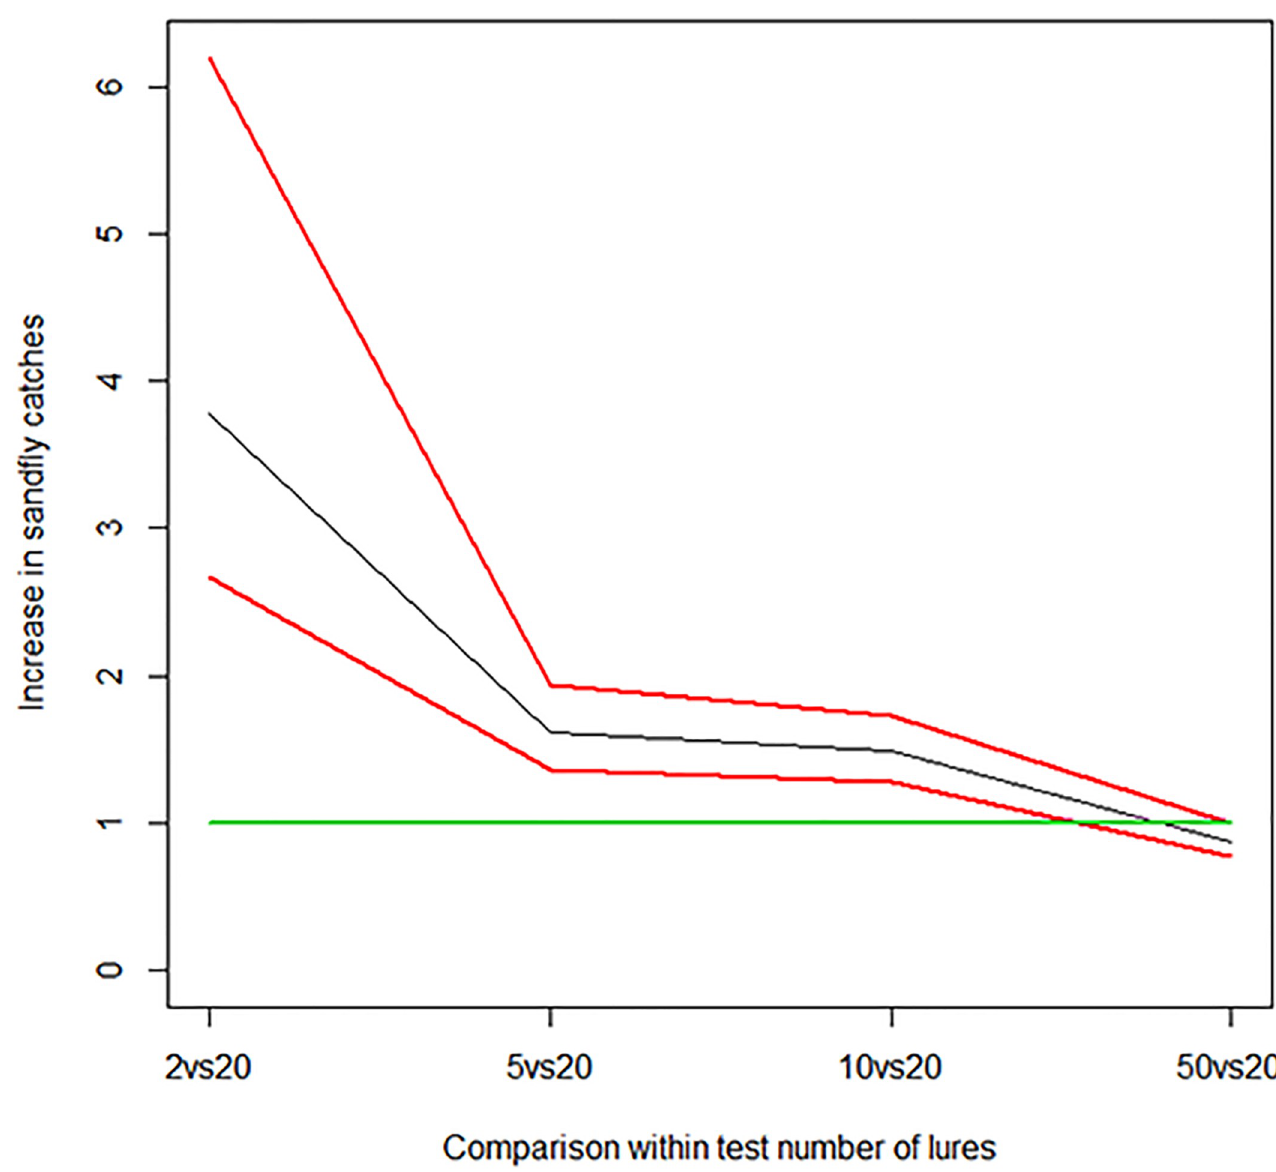
Fig 2. Comparison of the β coefficients for the different levels of pheromones. The 95% CR limits are shown in red. The green line is the ratio of 1 (identical coefficients, no change in capture rate).